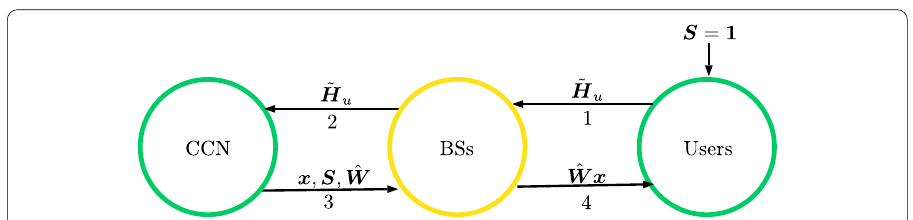
Fig. 3 Representation of data flow in the proposed JT-CoMP system with sparse feedback and constrained